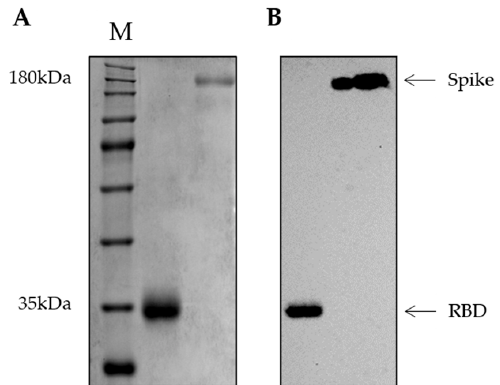
Figure 1. RBD and full-length spike recombinant proteins purification. ( A ) 10% SDS-PAGE in denaturing conditions showing the RBD and full-length spike purification. ( B ) Western blot of RBD and spike purified fractions, using commercial rabbit anti-His-tag antibody (1:1000, M: TrueColor High Range Protein Marker); The images from SDS-PAGE and blot were adjusted for brightness and contrast and were recorded.